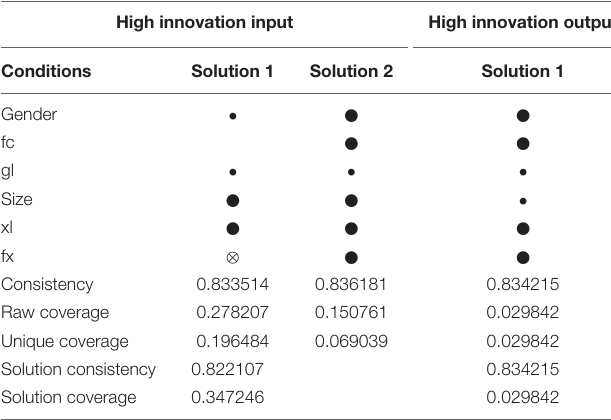
TABLE 5 | Sufficiency analyses results for high innovation input and